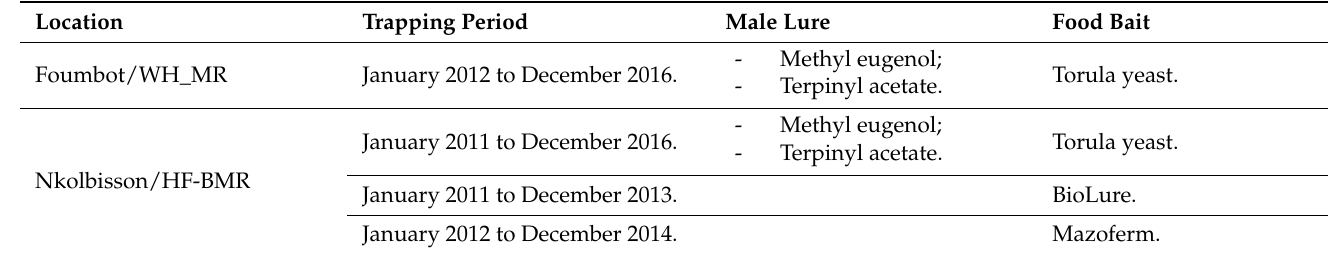
Table 2. Attractants used for fruit fly trapping in two agro-ecological zones—WH and